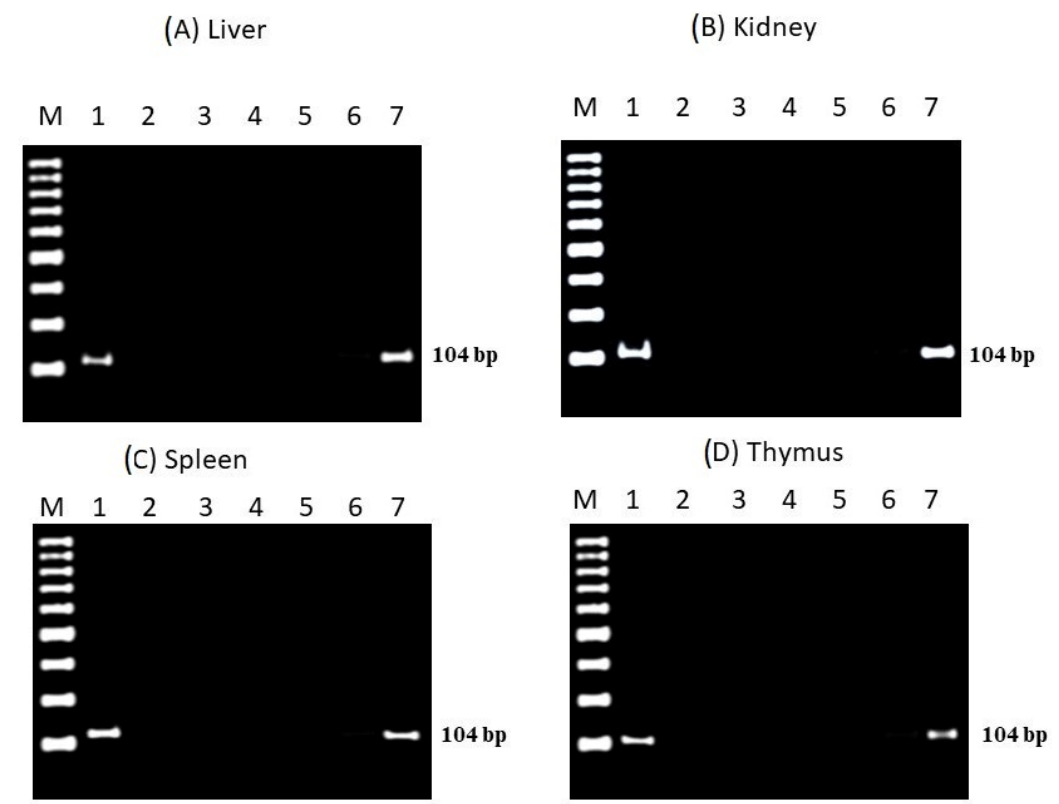
Figure 16. PCR for sry gene in the liver ( A ), kidney ( B ), spleen ( C ), and thymus gland ( D ) of rats; M: 100 bp DNA maker; sry: 104 bp, lane 1: Control positive; lane 2: Control negative; lane 3: OLE; lane 4: Cis; lane 5: Cis + OLE; lane 6: Cis + CM-MSC; lane 7: Cis + MSC.